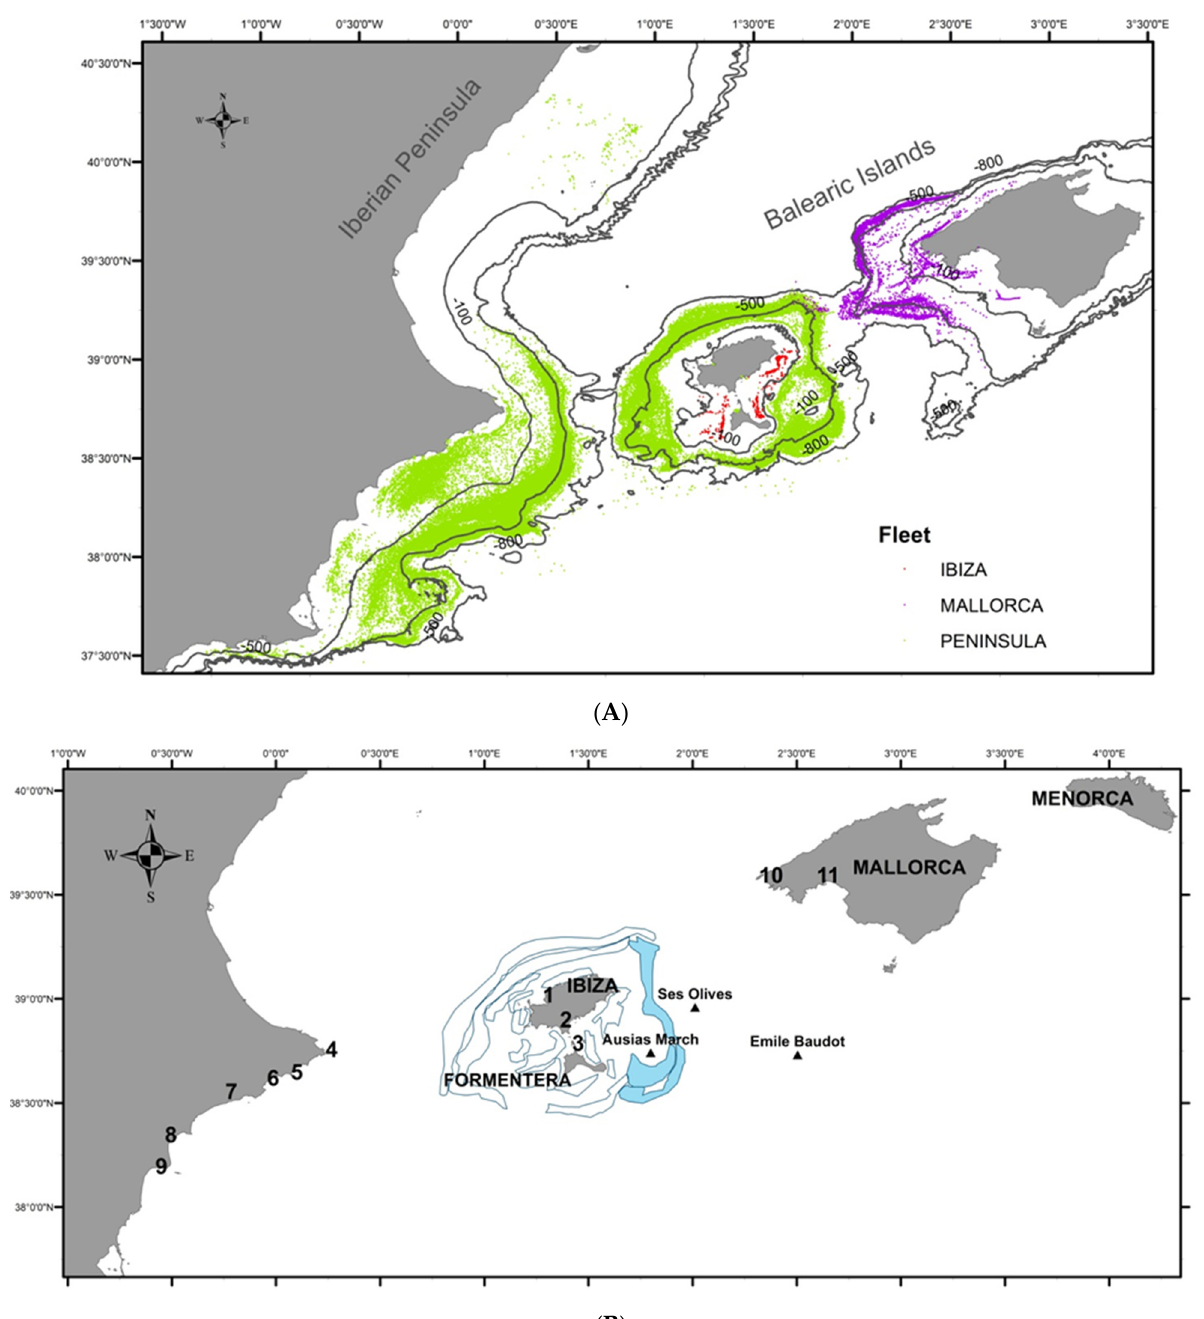
Figure 8. Bottom trawl fishing activity in the seamounts of the Mallorca Channel: ( A ) VMS signals during the period 2016–2019 of the fleets that operate around Ibiza and the Formentera Islands (red: vessels from ports on these islands; green: vessels from ports on the Iberian Peninsula; violet: vessels from ports on Mallorca Island), showing the three seamounts studied and the whole fishing areas of these fleets along the northwestern Mediterranean; and ( B ) fishing grounds located in adjacent bottoms of the Ses Olives and Ausias March seamounts, identified from the cartography of all fishing grounds around the Balearic Islands from VMS signals [60], showing the base port fleets operating in the study area: (1) Sant Antoni de Portmany; (2) Eivissa; (3) La Savina; (4) Xàvia; (5) Calp; (6) Altea; (7) La Vila Joiosa; (8) Alicante; (9) Santa Pola; (10) Andratx; and (11) Palma. Three different fishing grounds were identified in the vicinity of SO and AM (Figure 8B): (i) one situated east and northeast of Ibiza Island, with its southern part including